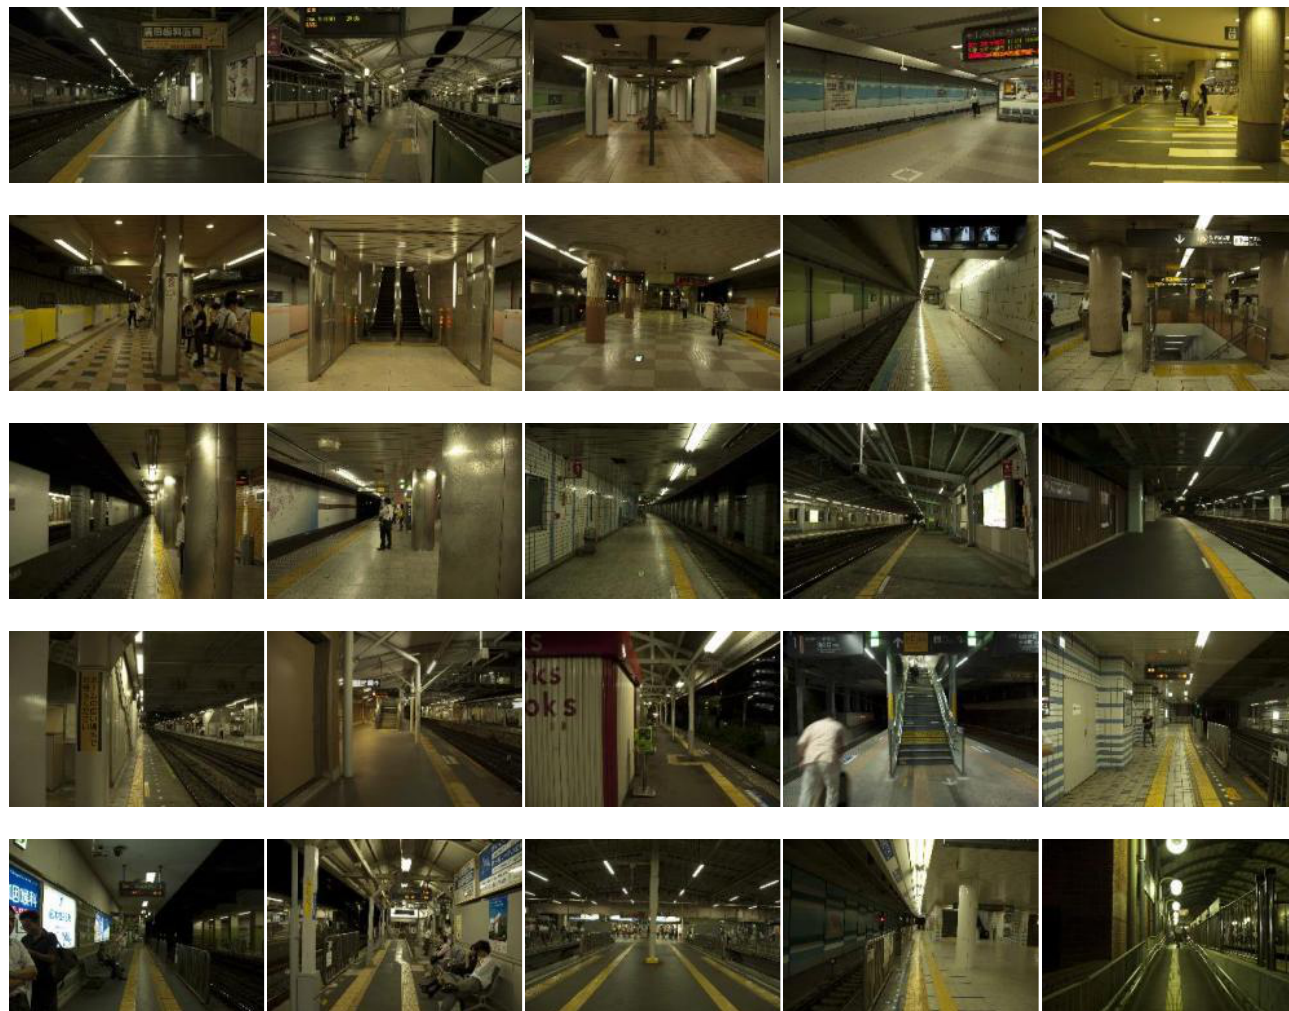
Figure 1. Front view of the platforms.